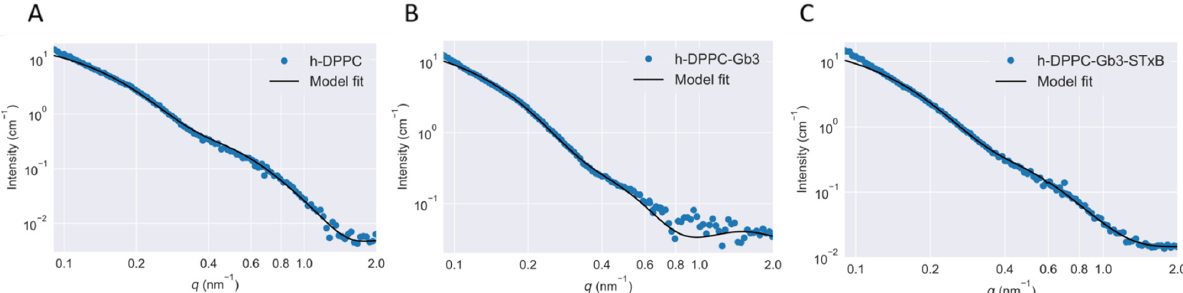
Figure 3. Optimized theoretical scattering functions on [h-DPPC]/[d-DPPC] = 1/0 system based on polydisperse three-shell model fitting. The SUV were prepared as [Gb3]/[DPPC] = 0.1/1. Measurements were performed at T = 25°C. ( A ) Empty DPPC vesicle; ( B ) Gb3 reconstructed DPPC vesicle; ( C ) Shiga toxin B subunit incubated with Gb3 reconstructed DPPC vesicle.